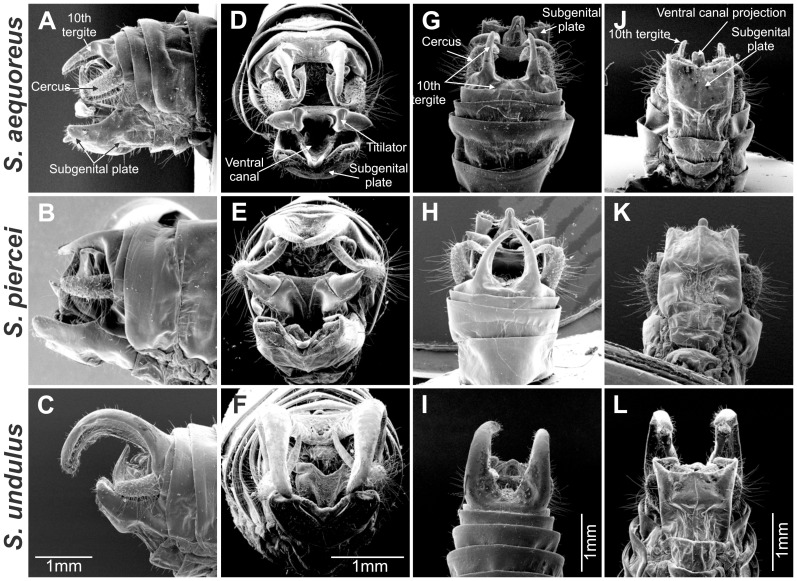
Male genitalia morphology comparison between Supersonus spp.(A–C) Lateral view. (D–F) Frontal view. (G–I) Dorsal view. (J–L) Ventral view. First row of images: S. aequoreus, middle row: S. piercei, and third row S. undulus.